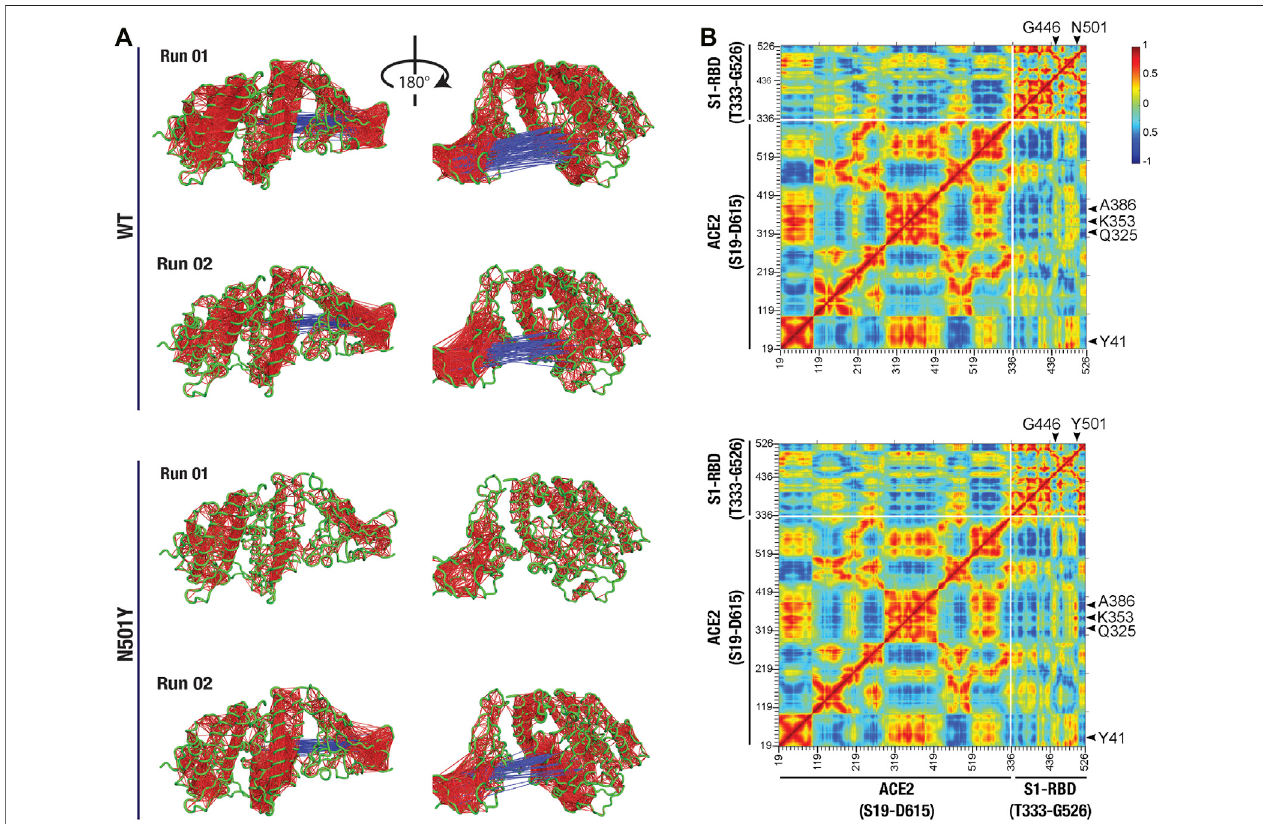
FIGURE 3| Altered dynamical cross-correlated motions in the ACE2-S1-RBD N501Y mutant complex. (A) Cartoon representation of ACE2-S1-RBD WT (top two panels) and N501Y mutant (bottom twopanels) complex showing DCCvalues(cut-off,±0.8). Note the positively correlated motions observed between Y501 and G502 on S1-RBD and residues K353 and G354 on ACE2 in the mutant complex but not in the WT complex, while less dynamically anti-correlated motions were observed in themutantcomplexcomparedtotheWTcomplex. (B) HeatmapshowingaverageDCCvaluesfromtwoindependent100nsMDsimulationsoftheWT(toppanel) andtheN501Ymutant(bottompanel)ACE2-S1-RBDcomplex(cut-off,±0.8).Notethehigherdynamicallycross-correlatedmotionsbetweenresiduesattheinterfacein the N501Y mutant complex. Also note the global decrease in the anti-correlated motions in the mutant